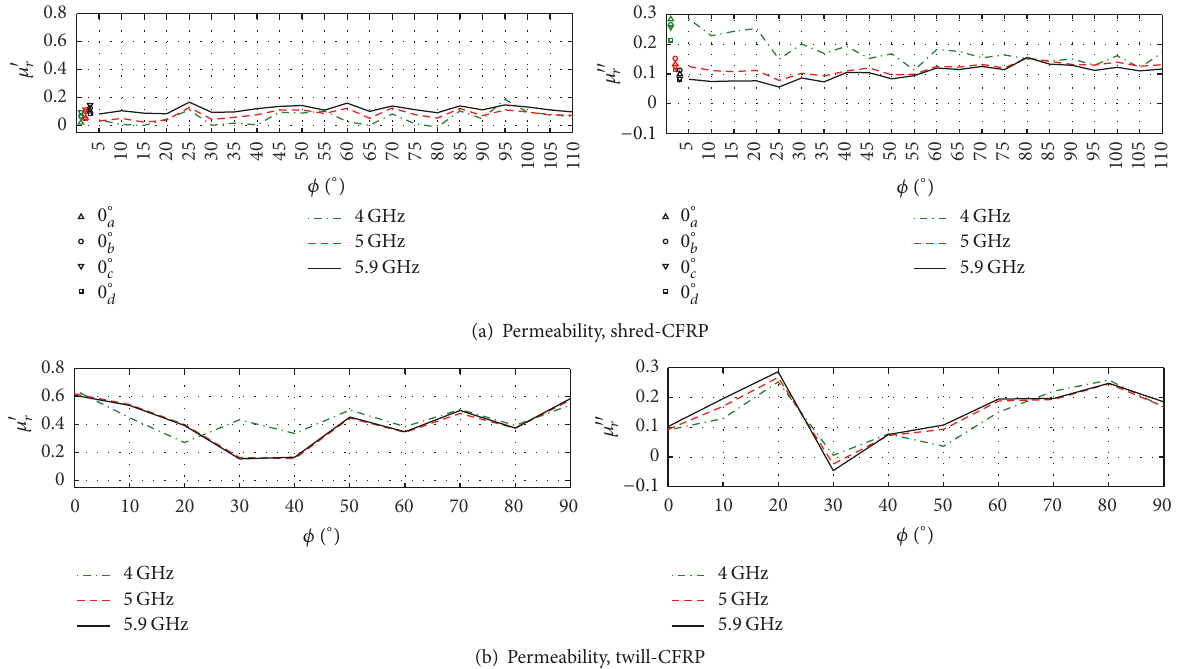
conductivity of shred-CFRP is about 10 4 S / m. Conductivity varies by a factor of 10 depending on the angle for a